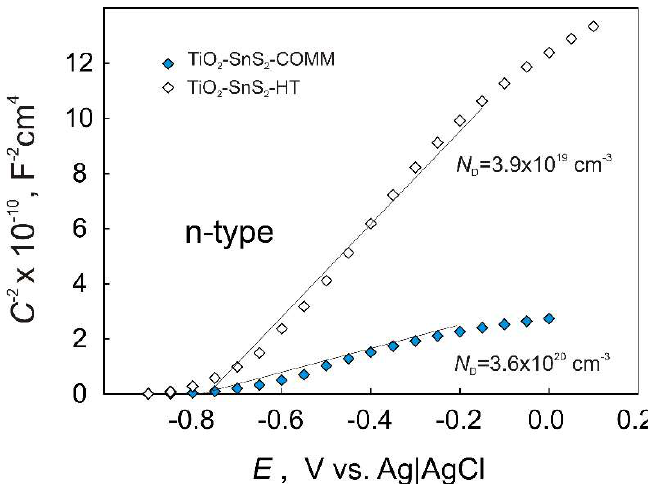
Figure 2. Mott–Schottky plots of the TiO 2 -SnS 2 -COMM and TiO 2 -SnS 2 -HT composite films recorded in NaCl solution. Table 3. Surface properties (specific surface area and point of zero charge values) of studied TiO 2 -SnS 2 composites (72.5:27.5 wt